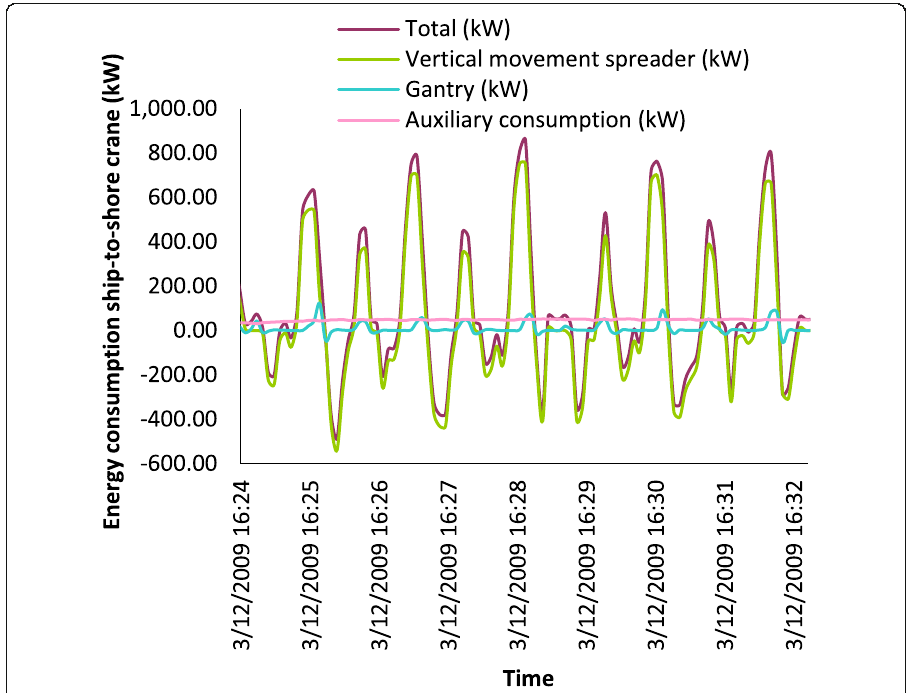
Fig. 1 Detailed energy consumption of quay crane (MSC Terminal Valencia 2009, field